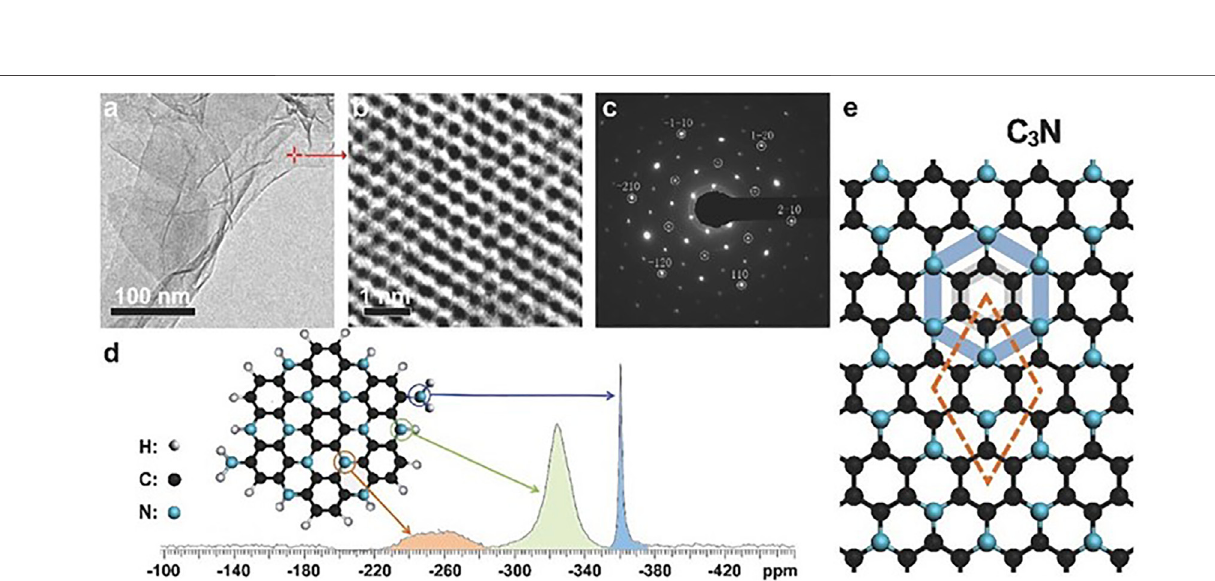
Frontiers in Materials |